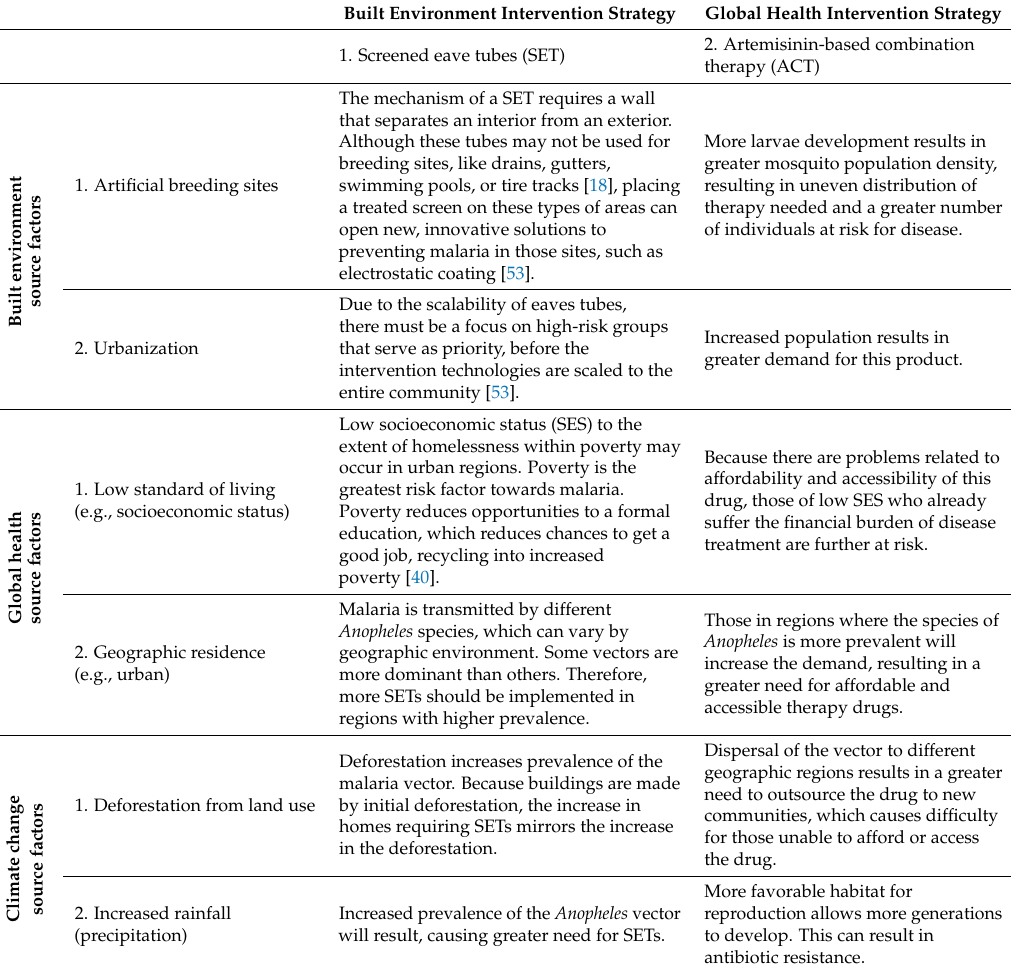
Table 5. Section of relevancy assessment matrix (Step